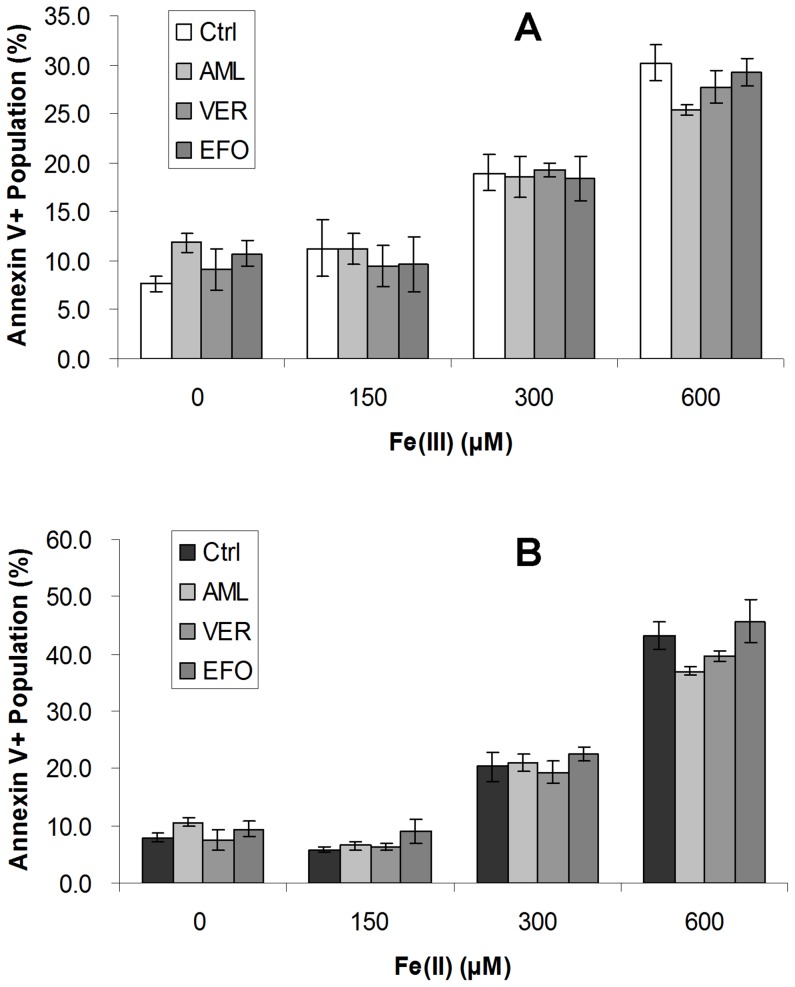
Calcium channel blockers could not salvage HL-1 cells from iron overload induced apoptosis.HL-1 cells were pretreated with LTCC blockers AML or VER, and TTCC blocker EFO for 1 hr, followed by Fe(III) (A) and Fe(II) (B) loading for 72 hr. Controls were defined as treatments without blockers. Apoptosis was determined by annexin V/PI flow cytometry assay. Total annexin V positive cell portion was counted. The results represented as mean ± SEM of three independent experiments.